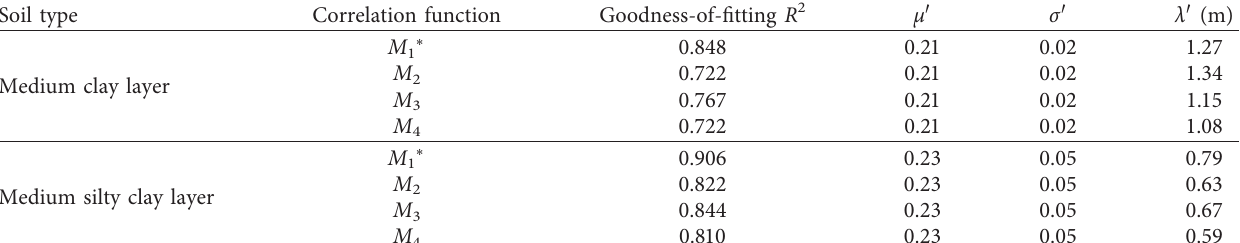
Table 4: Results of random field parameters and correlation function of r of the medium clay layer and medium silty clay layer obtained from conventional statistical analyses.